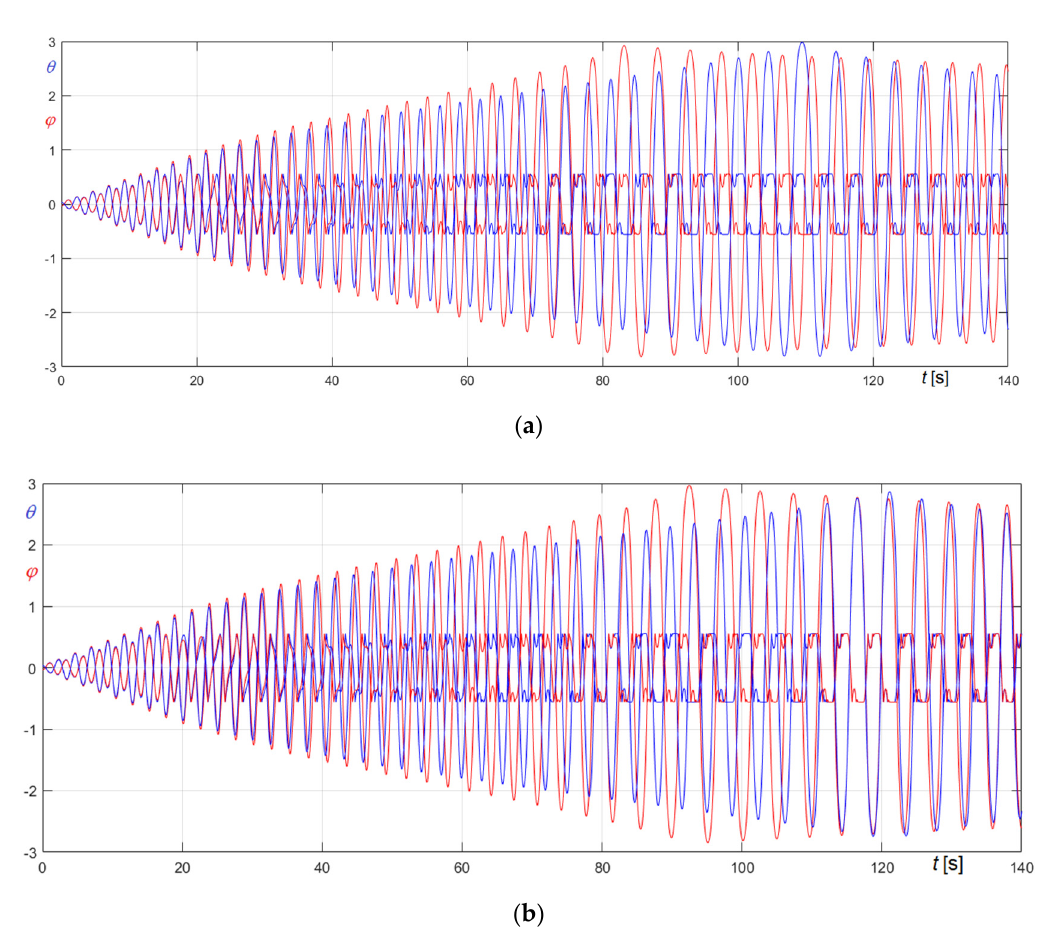
Figure 23. Comparison of time histories in the transient phase ( θ = θ ( t ) curves in red in the undamped case, in blue in the damped case; ϕ = ϕ ( t ) curves in blue in the undamped case, in red in the damped case): ( a ) M e 1 forcing function (Equation (74)); ( b ) M e 2 forcing function (Equation